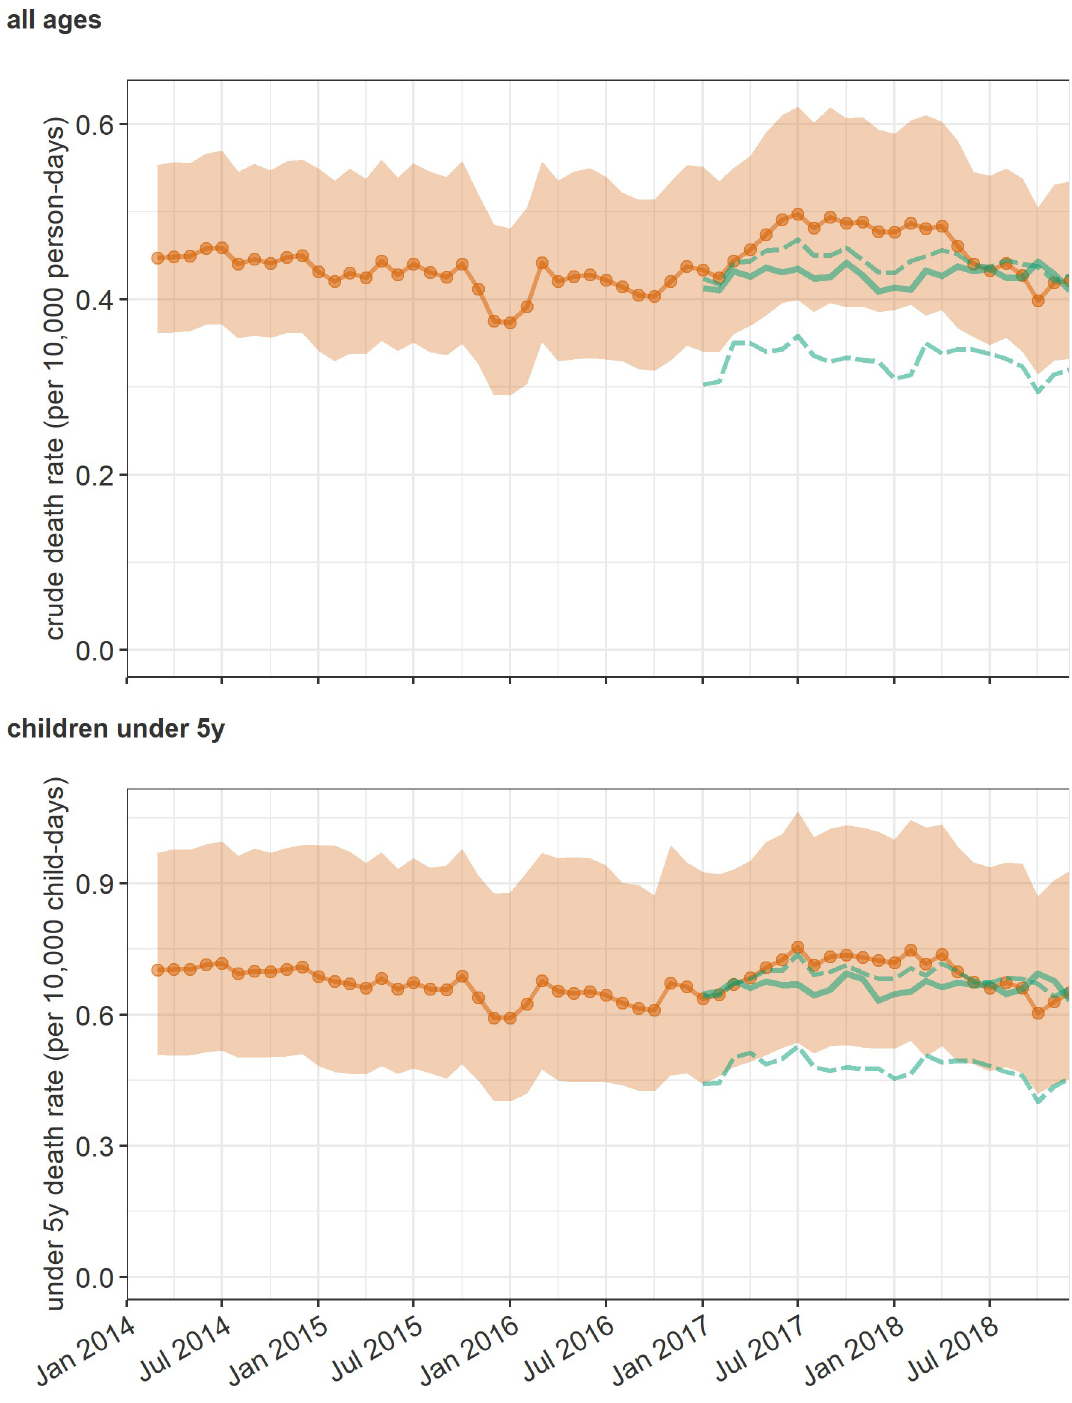
Fig 5. Trends in the estimated crude death rate (top panel) and under 5 years death rate (bottom panel). Actual estimates, i.e. under observed conditions, are shown with a dotted solid orange line (point estimate) and orange shaded area (95%confidence interval). The green lines indicate counterfactual levels (most likely scenario: Solid green line; reasonable worst-case and best-case scenario: Dashed green lines).